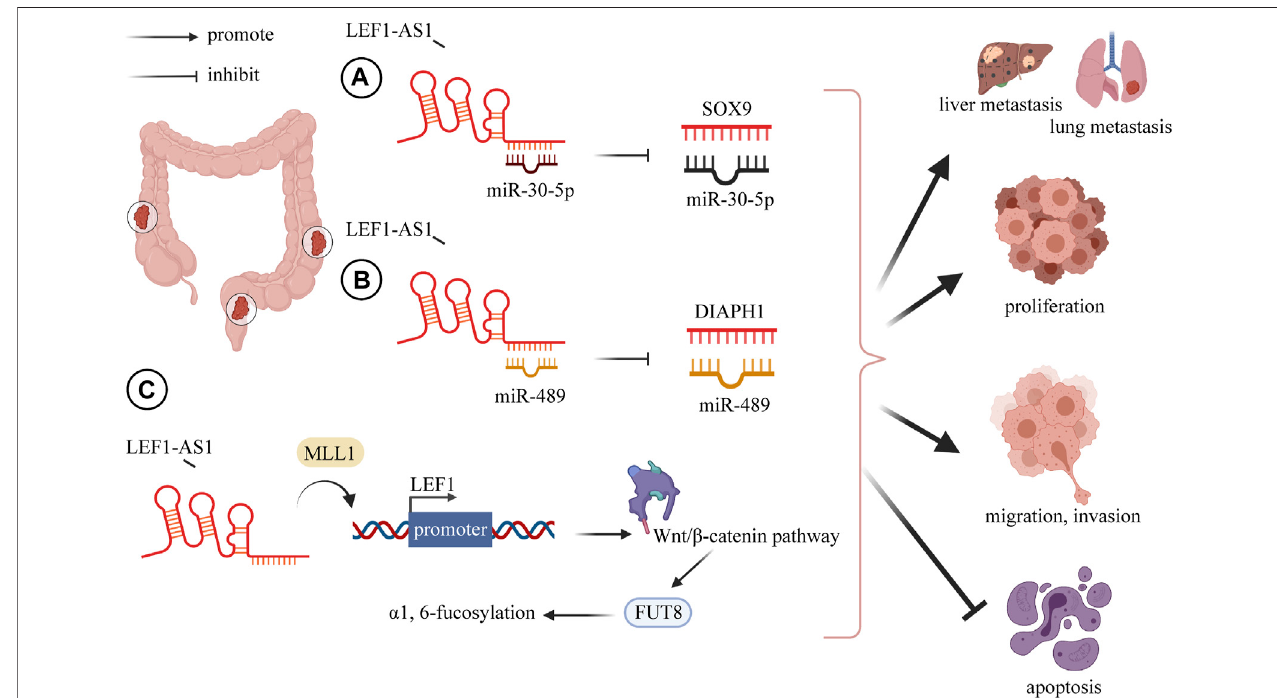
FIGURE1| LncRNALEF1-AS1playsacarcinogenicroleinCRC,overexpressionofLEF1-AS1promotesCRCproliferation,invasion,migration,distantmetastasis (liverandlung),andinhibitsapoptosis. (A) LEF1-AS1bindstomiR-30-5pandmediatestheexpressionofSOX9bynegativelyregulatingmiR-30-5p. (B) LEF1-AS1binds to miR-489 and mediates the expression of DIAPH1 by negatively regulating miR-489. (C) LEF1-AS1/LEF1/FUT8 axis mediates colorectal cancer progression by regulating α 1, 6-fucosylation via Wnt/ β -catenin pathway. Abbreviations: LEF1-AS1, lymph enhancer-binding factor 1-antisense RNA 1; CRC, colorectal cancer; SOX4, SRY-related HMG box transcription factor 4; DIAPH1, diaphanous related formin